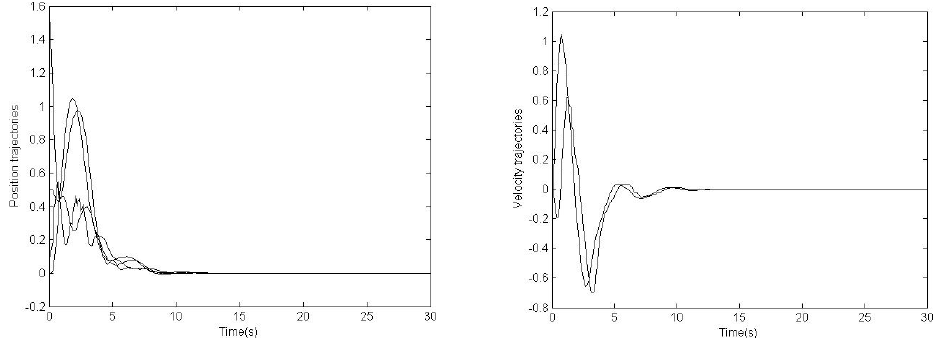
Figure 2. Trajectories of systems (1), (3), (4) with consensus algorithm (7).